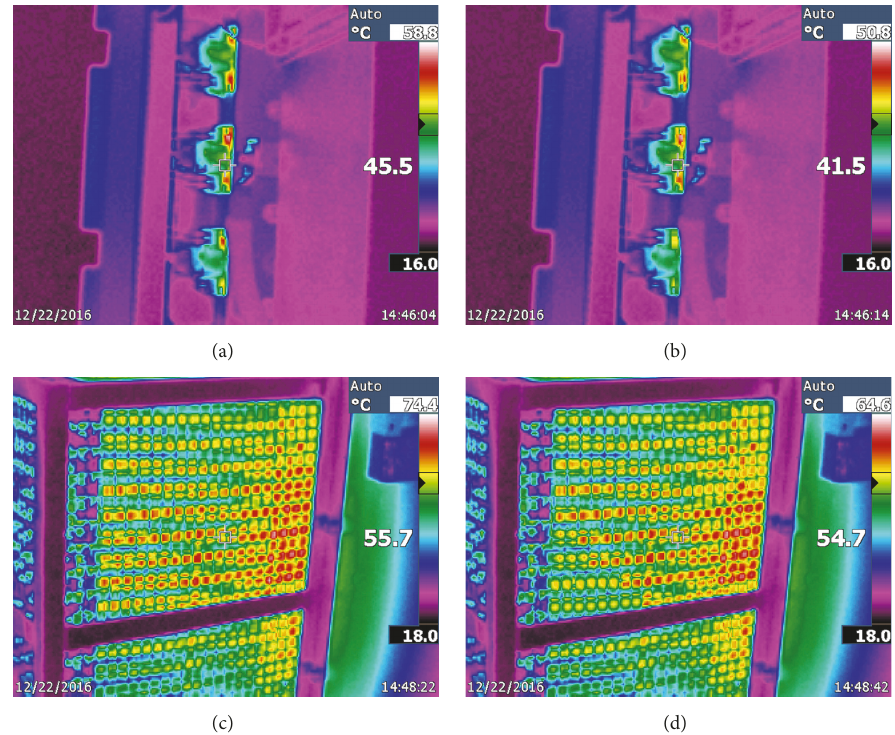
Figure 13: Surface and the substrate temperature rises of IGBT based on holographic equivalent dual mode. (a) Surface temperature rise of IGBT based on simplified SVPWM; (b) surface temperature rise of IGBT based on quasi-square-wave modulation; (c) substrate temperature rise of IGBT based on simplified SVPWM; (d) substrate temperature rise of IGBT based on quasi-square-wave